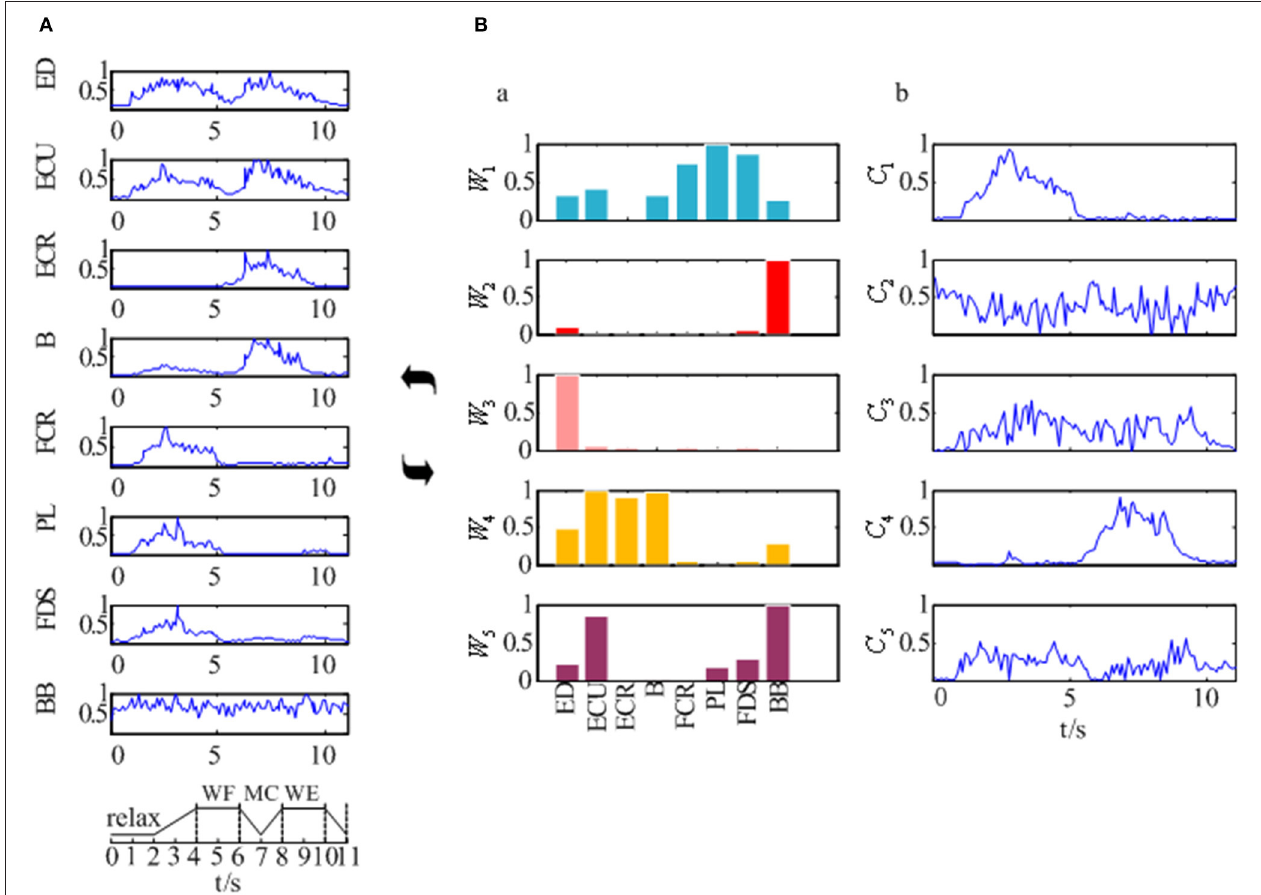
FIGURE 4 | The synergy muscle analysis based on the NMF. (A) The preprocessed EMG signals of the eight muscles. (B) Muscle activation model based on the NMF. (B-a) Muscle synergy matrix. (B-b) Time-varying synergy